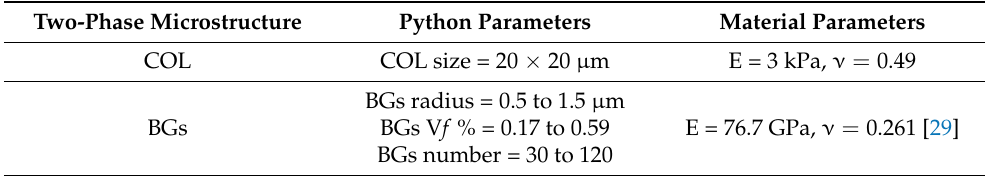
Table 1. Microstructural images of BG-COL